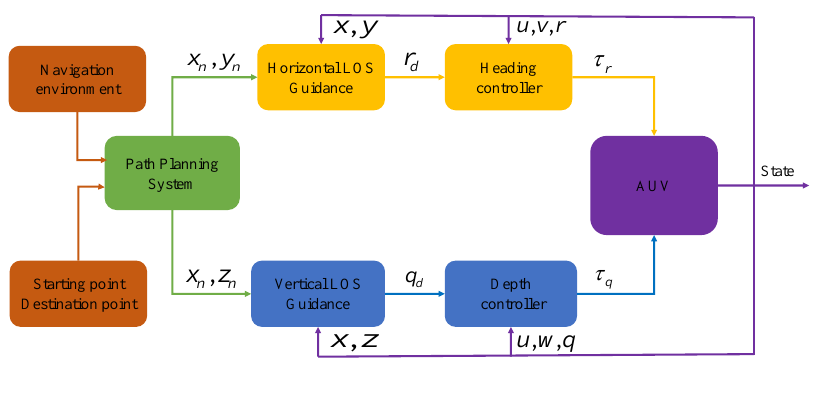
Figure 2. The block diagram of the 3D guidance